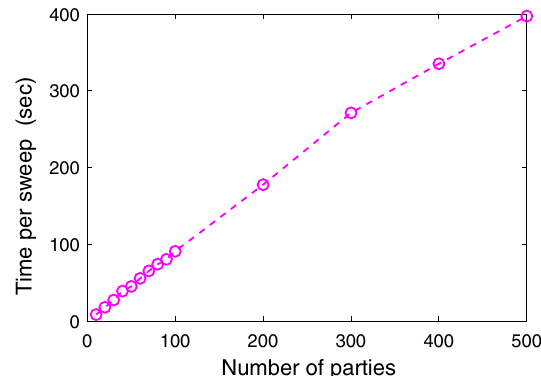
FIG. 13. Scalability. Computational time (in seconds) for a single seesaw sweep for optimization of Bell nonlocality con- nectors where bond dimension ¼ ð 2 ; 2 Þ grows approximately linearly with number of parties. Simulations are run on a regular laptop with 2.5-GHz CPU and 8-GB